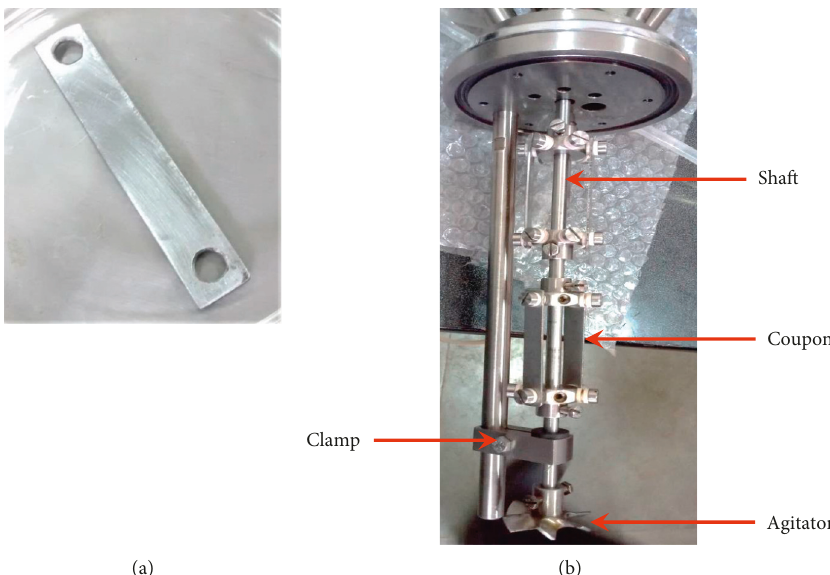
Figure 2: (a) Test coupon. (b) Photograph of the shaft, coupon assembly, and agitator (only 2 coupons shown attached at each